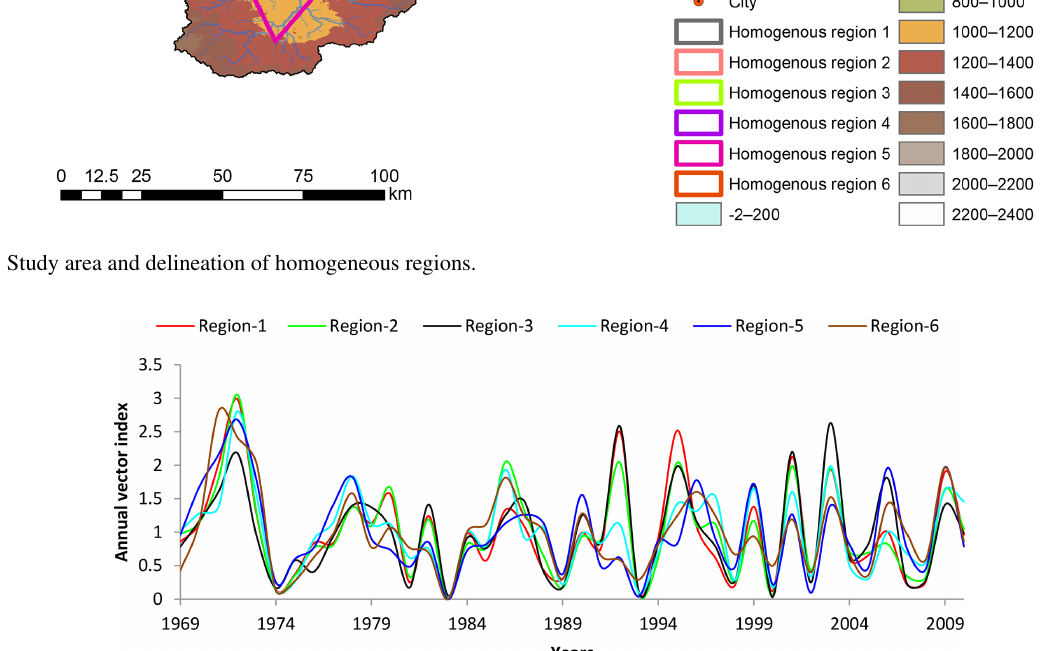
Figure 2. Evolution of the annual vectors in the six